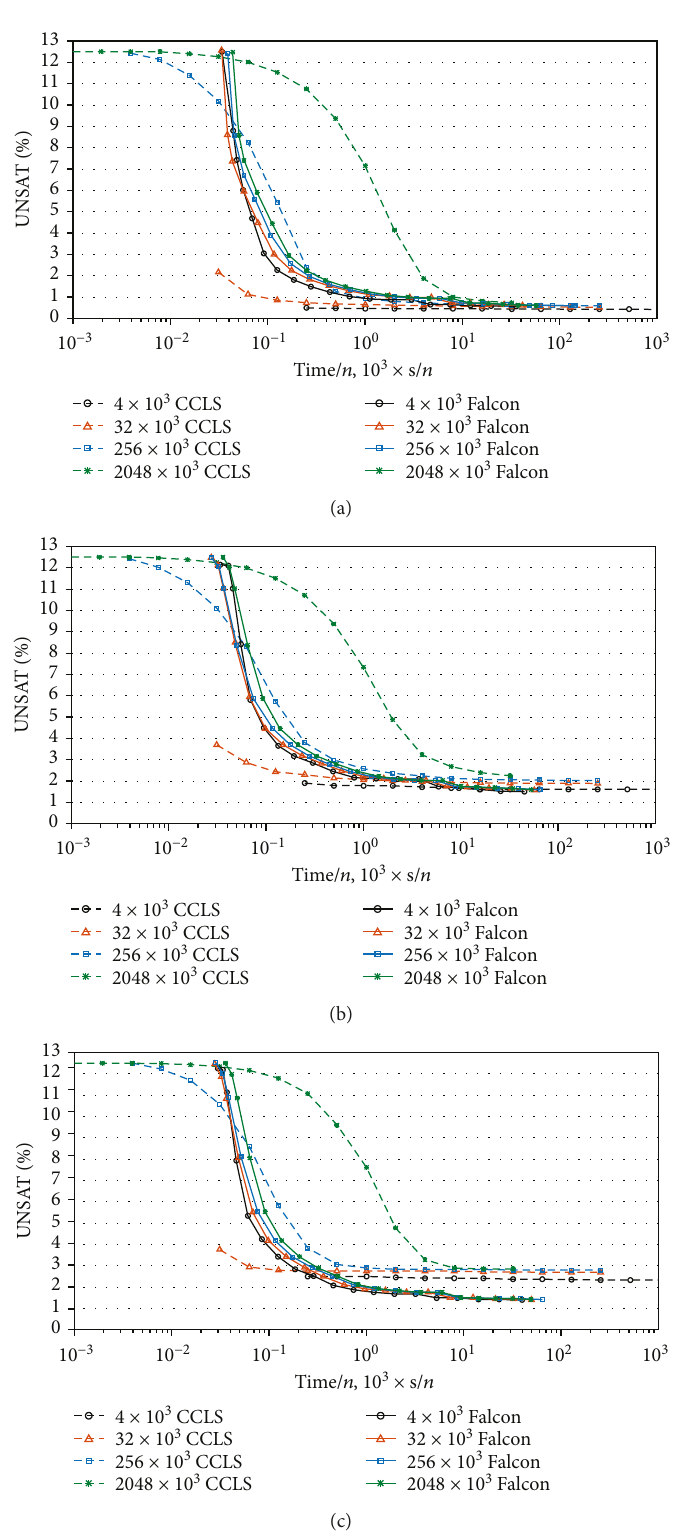
Figure 3: Comparison between the incomplete solver CCLS versus our noncombinatorial solver, Falcon, for (a) random-Max-E3SAT, (b) hyper-Max-E3SAT, and (c) delta-Max-E3SAT. In these plots, the percentage of unsatis fi ed clauses versus the time normalized with respect to the number of variables is shown to highlight the linear scaling of our solver. All calculations have been performed on a single thread of an Intel Xeon E5-2680 v3 with 128Gb DRAM shared on 24